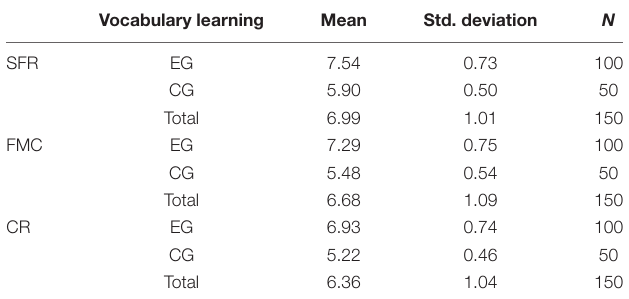
TABLE 8 | Descriptive statistics results comparing experimental group (EG) and control group (CG) on spoken-form recognition (SFR), form-meaning connection (FMC), and collocation recognition (CR) scores on the delayed post-test.